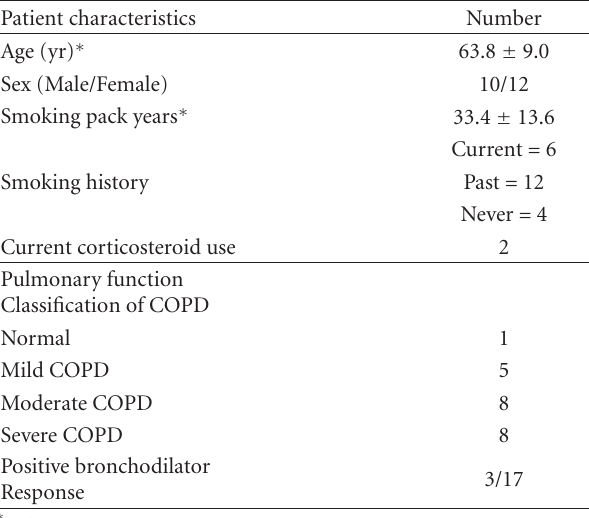
Table 1: Patient characteristics and pulmonary function